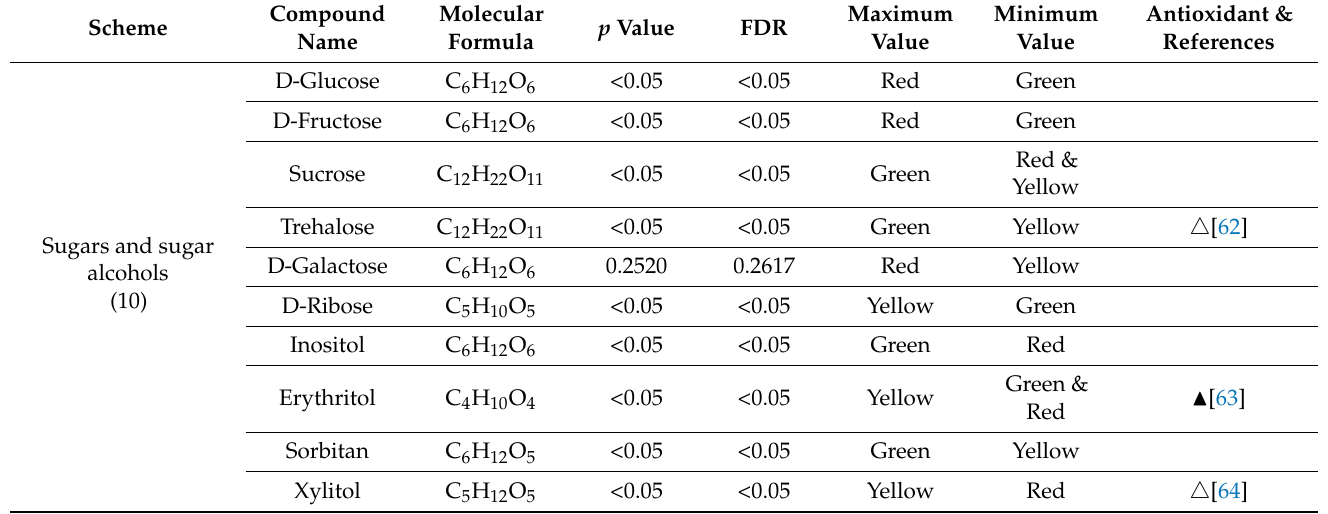
Table 2. List of identified metabolites.